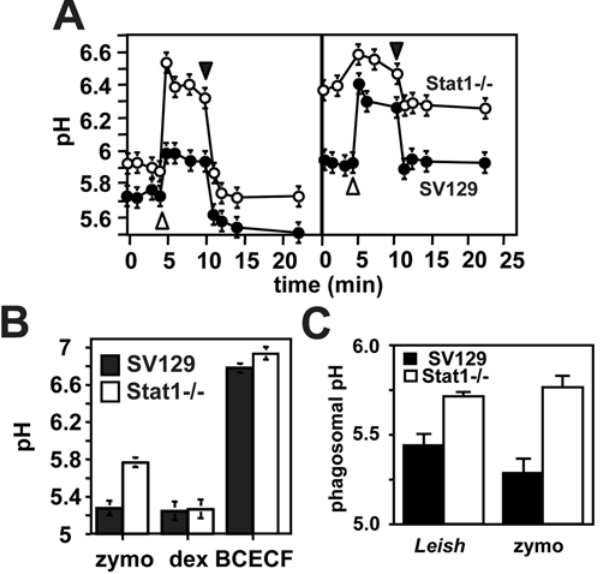
Figure 3. Stat1 2 / 2 phagosomes show a selective defect in phagosomal acidification. (A) Phagosomal pH-measurement. Mono- layers of untreated (left panel) or LPS/IFN c treated (right panel) SV129 control and Stat1 2 / 2 PEMs were established on 1 by 2.5 cm glass slides and pH of phagosomes containing FITC-labeled zymosan was determined by ratio-fluorescence determination. Calibration for fluo- rescence was done in situ. The fraction of particles bound to and remaining on the cell surface was controlled for and found to be negligible by measurement of the response to alterations in the pH of the external buffer. Each experiment was performed in duplicate and repeated at least three times. The graph shows a representative time course measurement of phagosome alkalinization upon addition of 10 m M NH 4 Cl (open arrow head), equilibration and removal (closed arrow head). (B) and (C) Measurement of intracellular pH. (B) Monolayers of SV129 control and Stat1 2 / 2 PEMs were incubated for 30 min with 10 m M BCECF-AM, overnight with 2.5 mg/ml FITC-dextran, or 2 h with FITC-labeled zymosan, and cytoplasmic, lysosomal, or phagosomal pH were assessed by ratio-fluorescence determination. The bars represent the standard deviation of three independent duplicate experiments. (C) Monolayers of SV129 control and Stat1 2 / 2 PEMs were infected for 2 h with FITC-labeled axenic L. donovani amastigotes (Leish) or incubated with FITC-labled zymosan (zymo), and phagosomal pH were assessed by ratio-fluorescence determination.